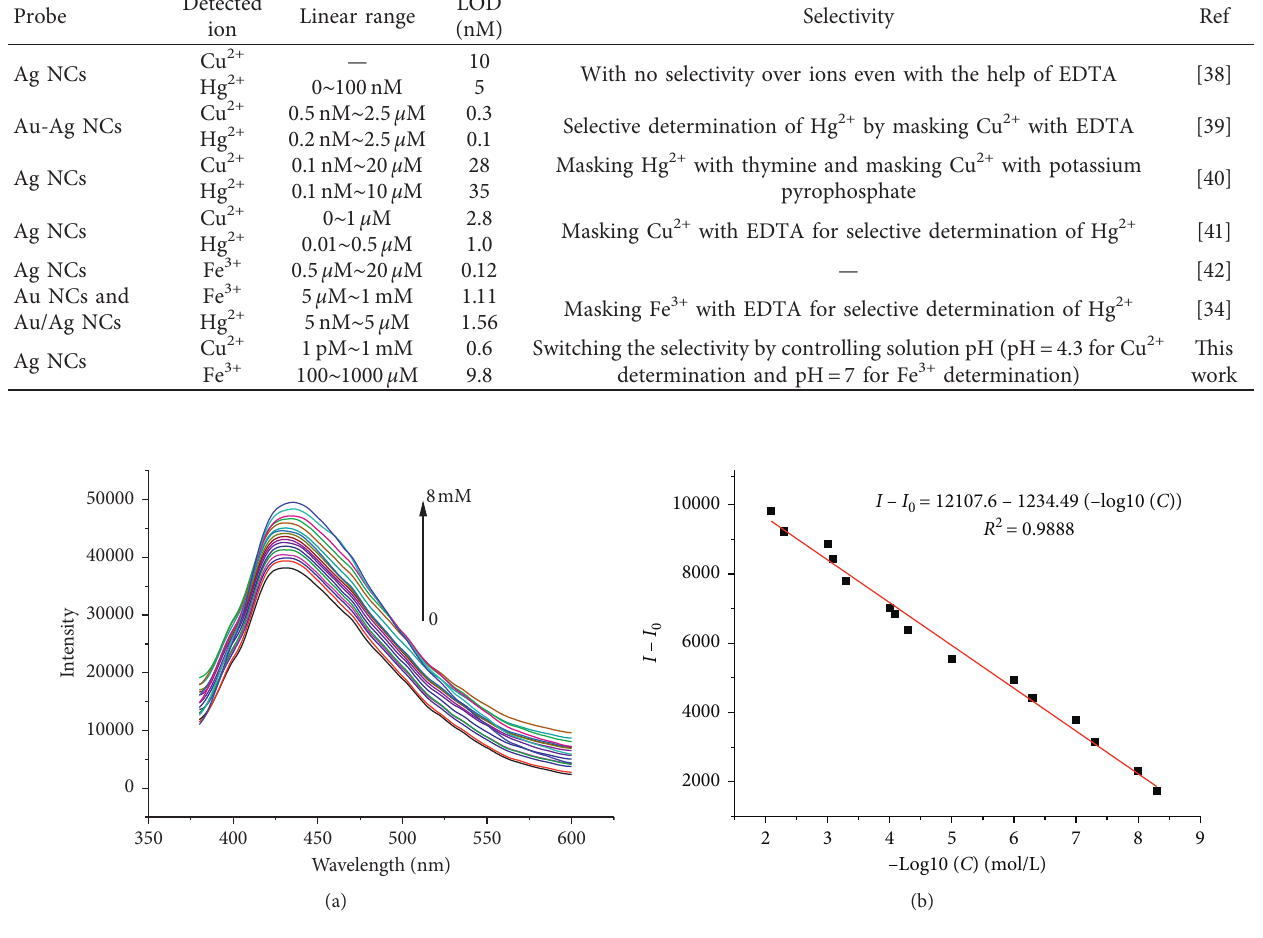
Figure 8: (a) GSH from bottom to top: 0 nM, 1nM, 5nM, 10nM, 50nM, 100nM, 500 nM, 1 μ M, 10 μ M, 100 μ M, 500 μ M, 800 μ M, 1mM, 5mM, and 8mM. (b) The linear calibration ranges of the fluorescence recovery to GSH concentrations. Table S1: the fluorescent lifetime of the Ag NCs. Figure S1: the HR-TEM image of the Ag NCs. The yellow line labels the lattice distance of the Ag. Figure S2: fluorescence spectrum of His solution (red), solution mixed with His and AgNO3 (blue), and Ag NCs solution (black) excited at 365 nm. Figure S3: fluorescence response of the Ag NCs upon ad- dition of different concentrations of Cu2+ from top to bottom: 0 mM, 1 mM, 2 mM, 4 mM, 6 mM, and 8 mM. Figure S4: time-resolved fluorescence spectrum of the Ag NCs upon addition of different concentrations of Cu2+: 0,1 mM and 1 nM. Figure S5: TEM images of the Ag NCs in the presence of Cu2+: (a) 1 mM. (b) 1 nM. ( Supplementary